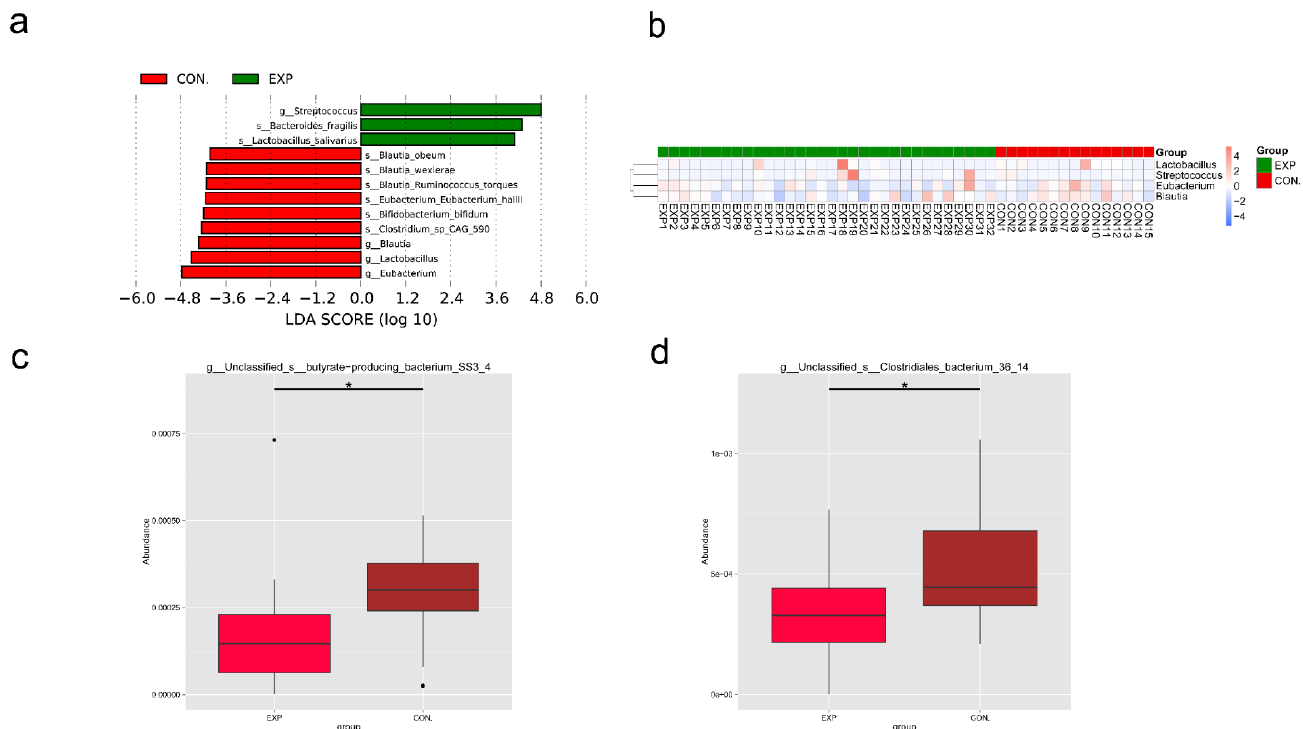
Figure 4. LEfSe and Metastat analysis of species differing between groups (BLCA patients, EXP group; healthy individuals, CON group). ( a ) Species with an LDA score greater than a set value (set to 4 by default) are shown. The length of the bar graph represents the effect size of the differential species (i.e., the LDA score). ( b ) Cluster heat map based on differential species. The clustering tree on the left is the species clustering tree, and the values corresponding to the middle heat map are the Z values obtained by normalizing the relative abundance of species in each row. ( c ) Metastat analysis of butyrate-producing bacterium SS3_4 . * indicates q-value < 0.05. ( d ) A Metastat analysis of Clostridiales bacterium 36_14 . * indicates q-value < 0.05.